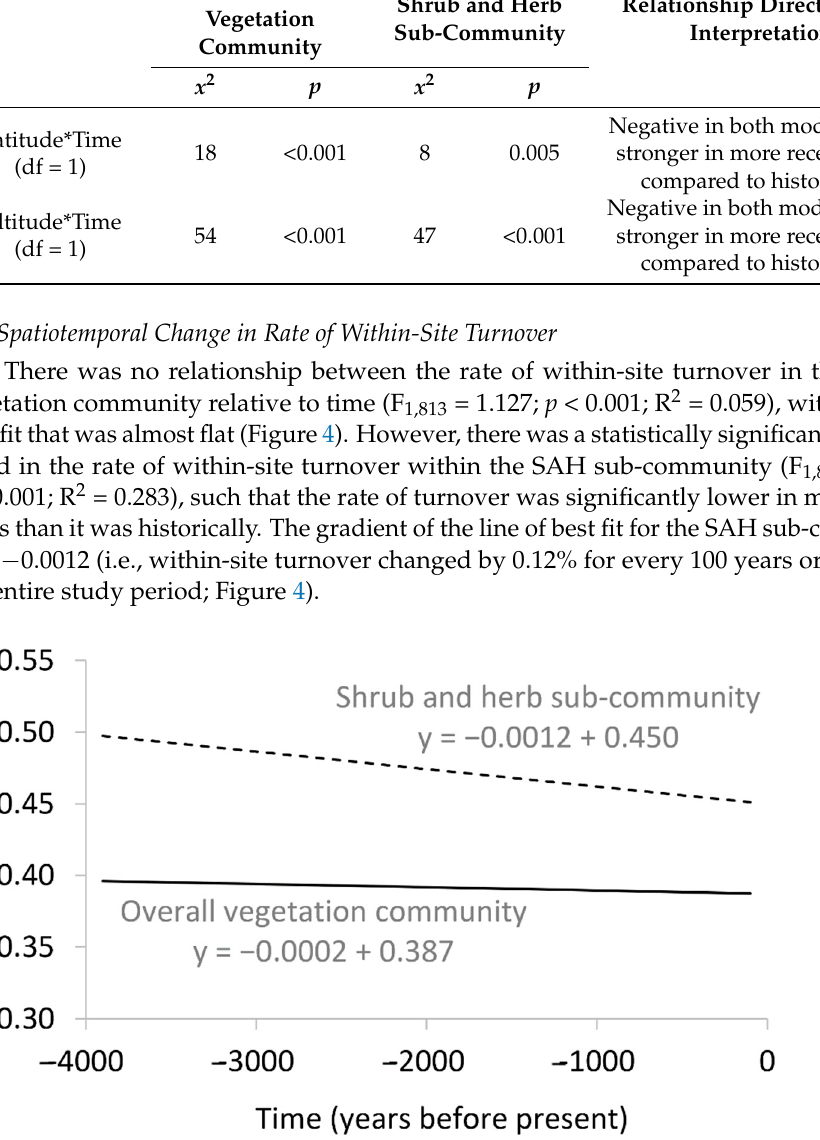
Figure 4. Schematic of the relationship between the rate of within-site turnover (higher = greater) in the overall vegetation community (solid line) and the shrub and herb sub-community (dashed line) at 23 sites in western Eurasia in relation to time. The equations were calculated using regression analysis on raw data (n = 813 in both cases) and values show the change in richness per 100 years.